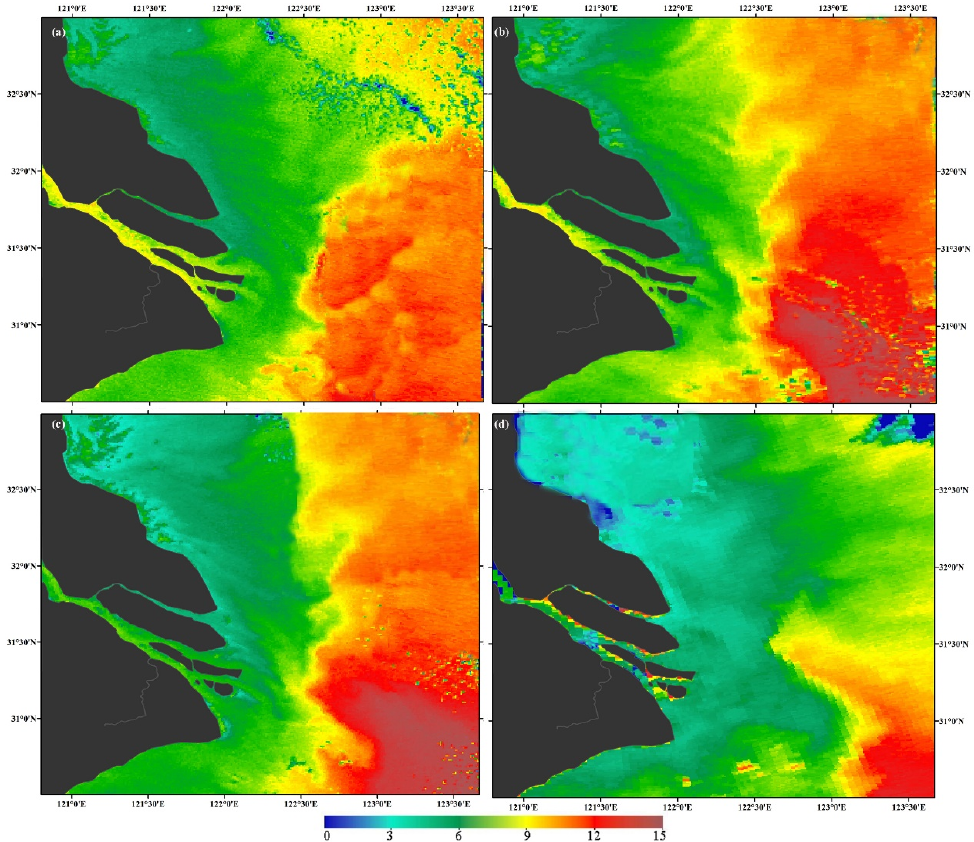
Figure 8. Characteristics of the temperature field in the Yangtze Estuary during the cold wave (where ( a – d ) represent the cold wave day data on 8 January 2015, 27 December 2021, 10 January 2018, and 15 January 2021, respectively).